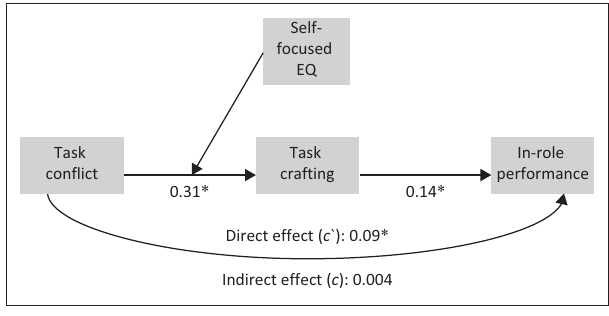
FIGURE 4: Conceptual model 1 showing first-stage moderated